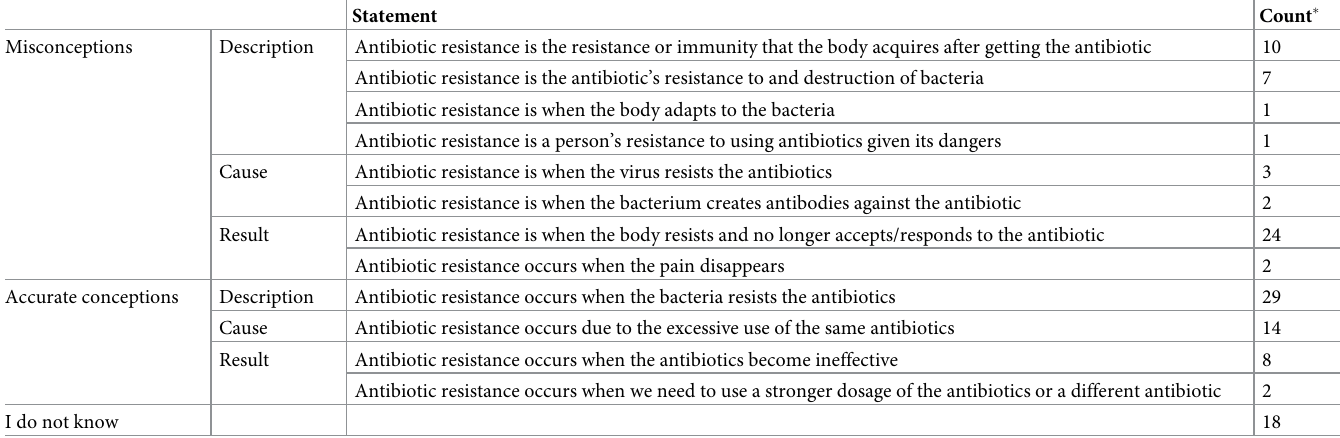
Table 9. Findings pertaining to Question 3: Do you understand what is meant by antibiotic resistance? How does this develop?.